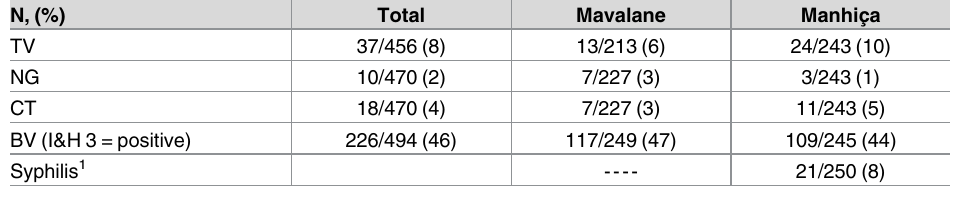
Table 4. STIs at